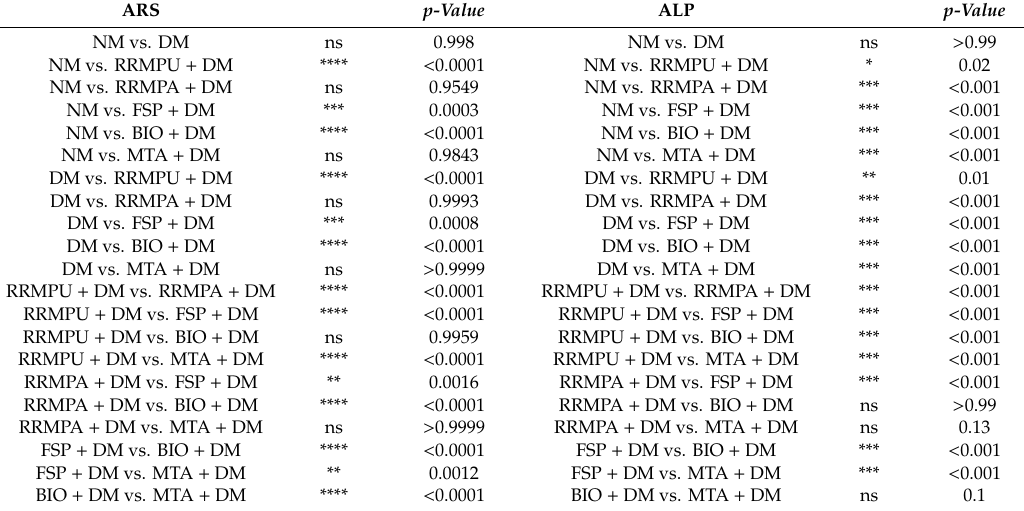
Figure 2. Alkaline phosphatase activity. Osteogenic differentiation was monitored by evaluation of alkaline phosphatase (ALP) activity: ALP levels were higher in MG-63 cells cultured in direct contact with FSP or RRMPU, compared with the cells grown in the presence of MTA. The ALP activity is expressed as absorbance at 405 nm. Table 2. Comparative analysis of the tested bioceramic materials. ARS alizarin red staining; ALP putty, RRMPA root repairing material paste, FSP root repairing material putty fast set, BIO Biodentine™, MTA mineral trioxide aggregate (ns = not significant, * p < 0.033, ** p < 0.002, *** p < 0.001, **** p < 0.0001).